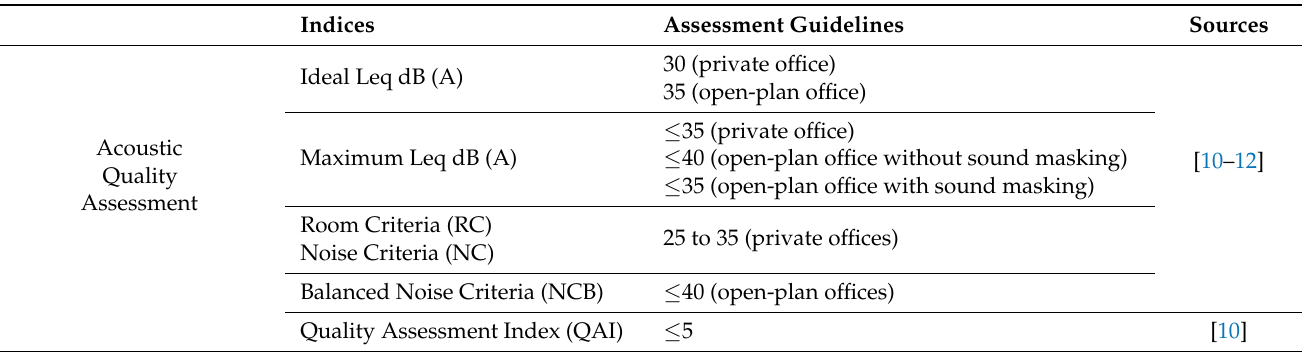
Table 2. Summary of Recommended Sound Criteria for Office